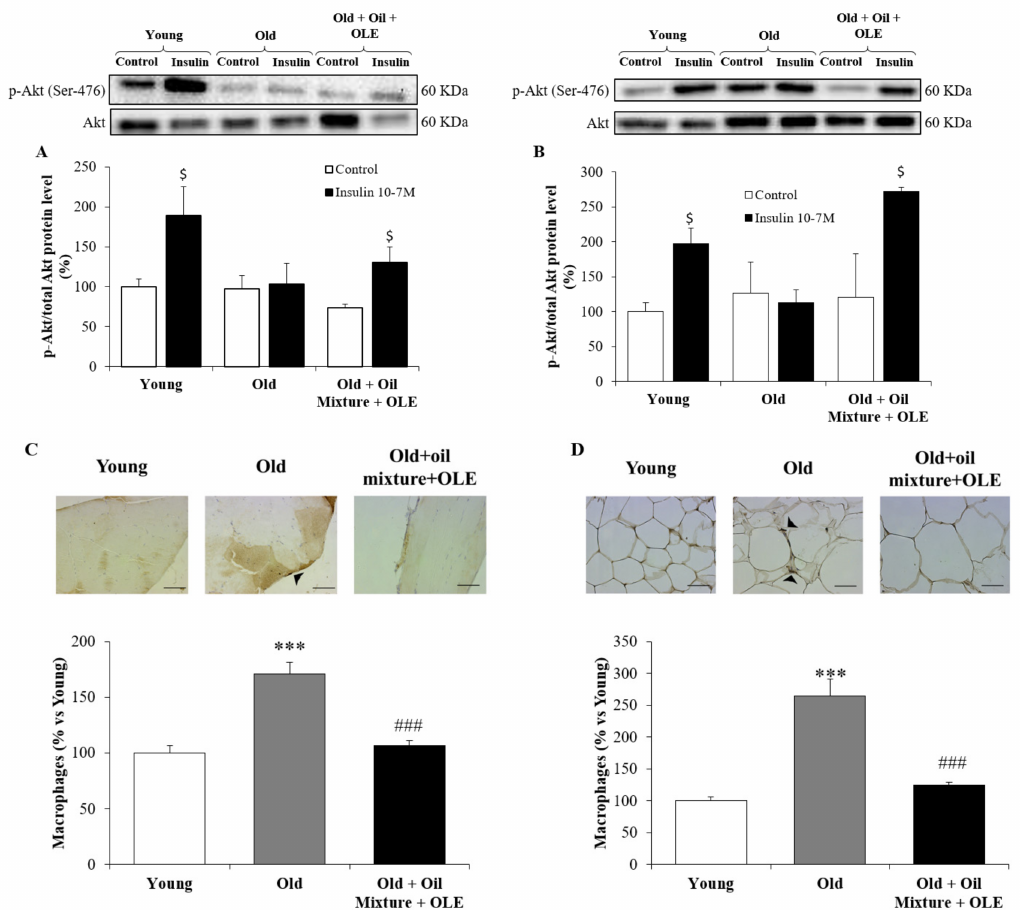
Figure 3. Ratio between protein levels of p-Akt and Akt in gastrocnemius ( A ) and epididymal visceral adipose tissue ( B ); and macrophages infiltration by immunohistochemistry in gastrocnemius ( C ) and epididymal visceral adipose tissue ( D ) of young rats, old rats and old rats treated 21 days with the Oil Mixture and the OLE. Values are represented as mean ± SEM. *** p < 0.001 vs. Young; ### p < 0.001 vs. Old; $ p < 0.05 vs. Control. Black line in the immunohistochemistry pictures represents 50 µ